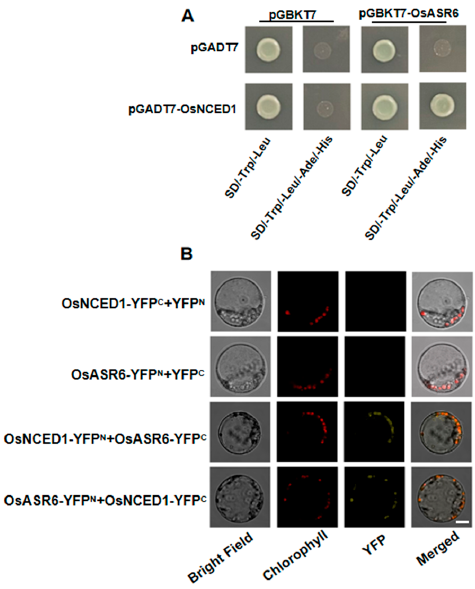
Figure 8. OsASR6 interacts with OsNCED1. ( A ) OsASR6 was found to interact with OsNCED1 in a yeast two-hybrid system. ( B ) A BIFC assay further confirmed the interaction in rice leaf protoplasts (scale bar: 10 μ m).